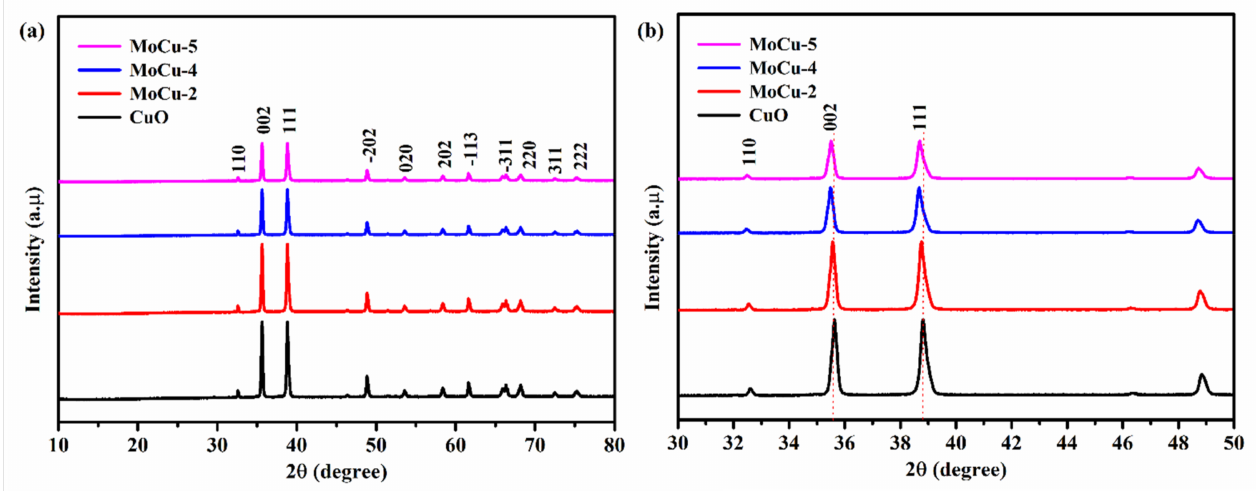
Figure 1. XRD pattern of pure CuO, MoCu-2, MoCu-4, and MoCu-5 samples. ( a ) 2 θ (degree) from 10–80; ( b ) 2 θ (degree) from